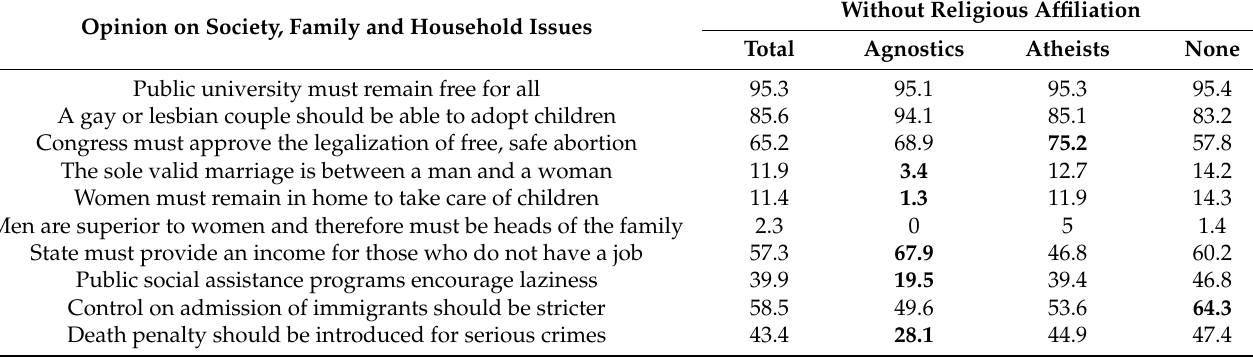
Table 5. Opinion on society, family and household issues 8 (in %).